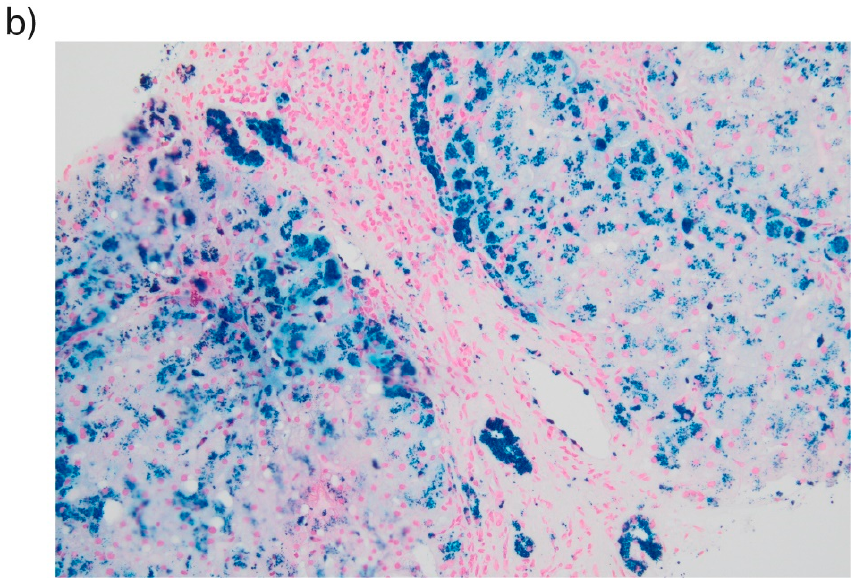
Figure A1. Liver biopsy of a patient with HJV-related hemochromatosis. ( a ). The specimen contains several pseudo-lobules and shows massive iron overload in Rappaport zone 1 and decreasing hemosiderin gradient from Rappaport zone 1 to 3 (Perls’ Prussian blue stain, 2X magnification). ( b ) A magnification (20X) of the previous image focusing a portal tract and part of the hepatic lobules showing massive hemosiderin granules in hepatocytes, biliocytes, macrophages and portal vein endothelium. Deugnier’s score: Total Iron Score 51 (Hepatic Iron Score 12,9,9; Sinusoidal Iron Score 3,3,3; Portal Iron score 4,4,4).